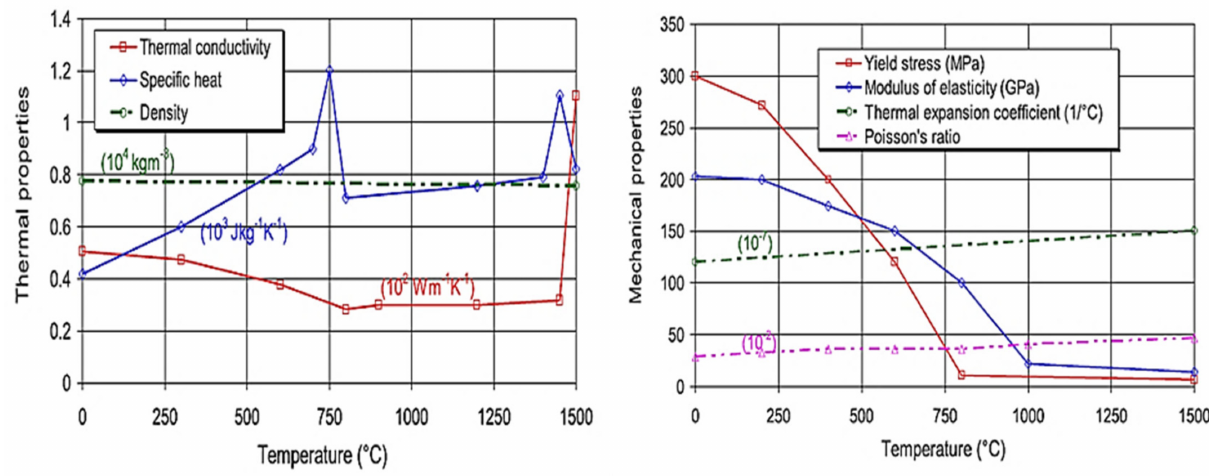
Figure 2. Thermal and mechanical material properties